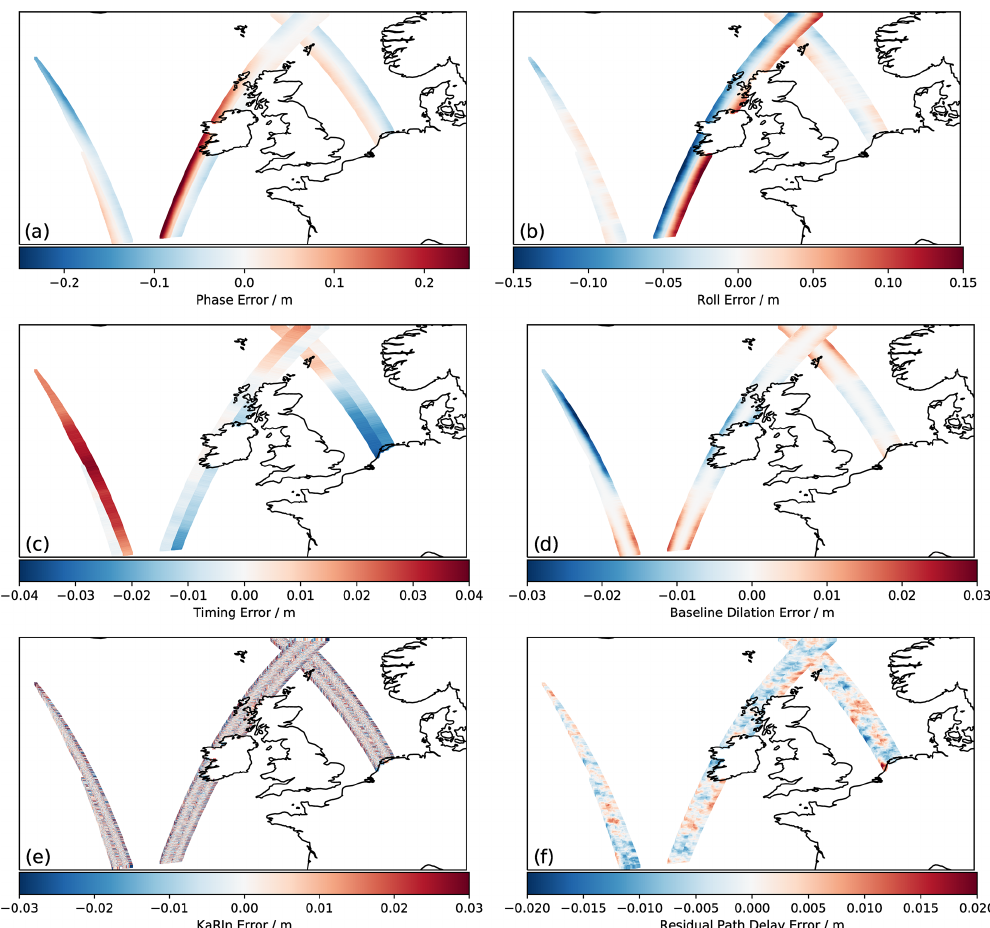
Figure 6. Individual components of the SWOT errors for an example day (31 October 2017): (a) phase error, (b) roll error, (c) timing error, (d) baseline dilation error, (e) KaRIn error and (f) residual path delay error. Note the difference in the scales for each error